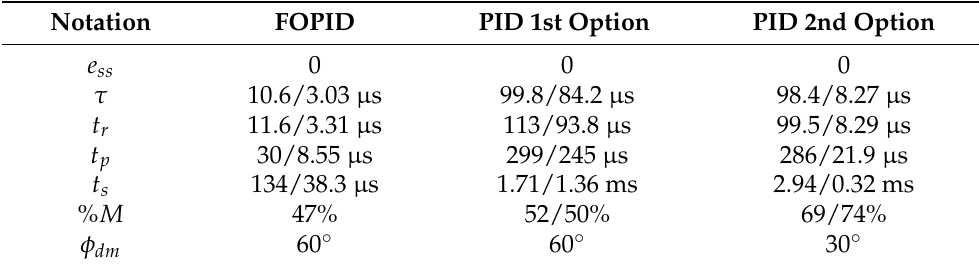
Figure 5. Closed-loop step response for both ( a ) buck and ( b ) boost conversion modes of converter in Figure 1. Table 4. Closed-loop response performance parameters for buck/boost conversion modes, where e ss , τ , t r , t p , t s and % M stand for steady-state error, time constant, rising time, peak time, settling time and overshoot,